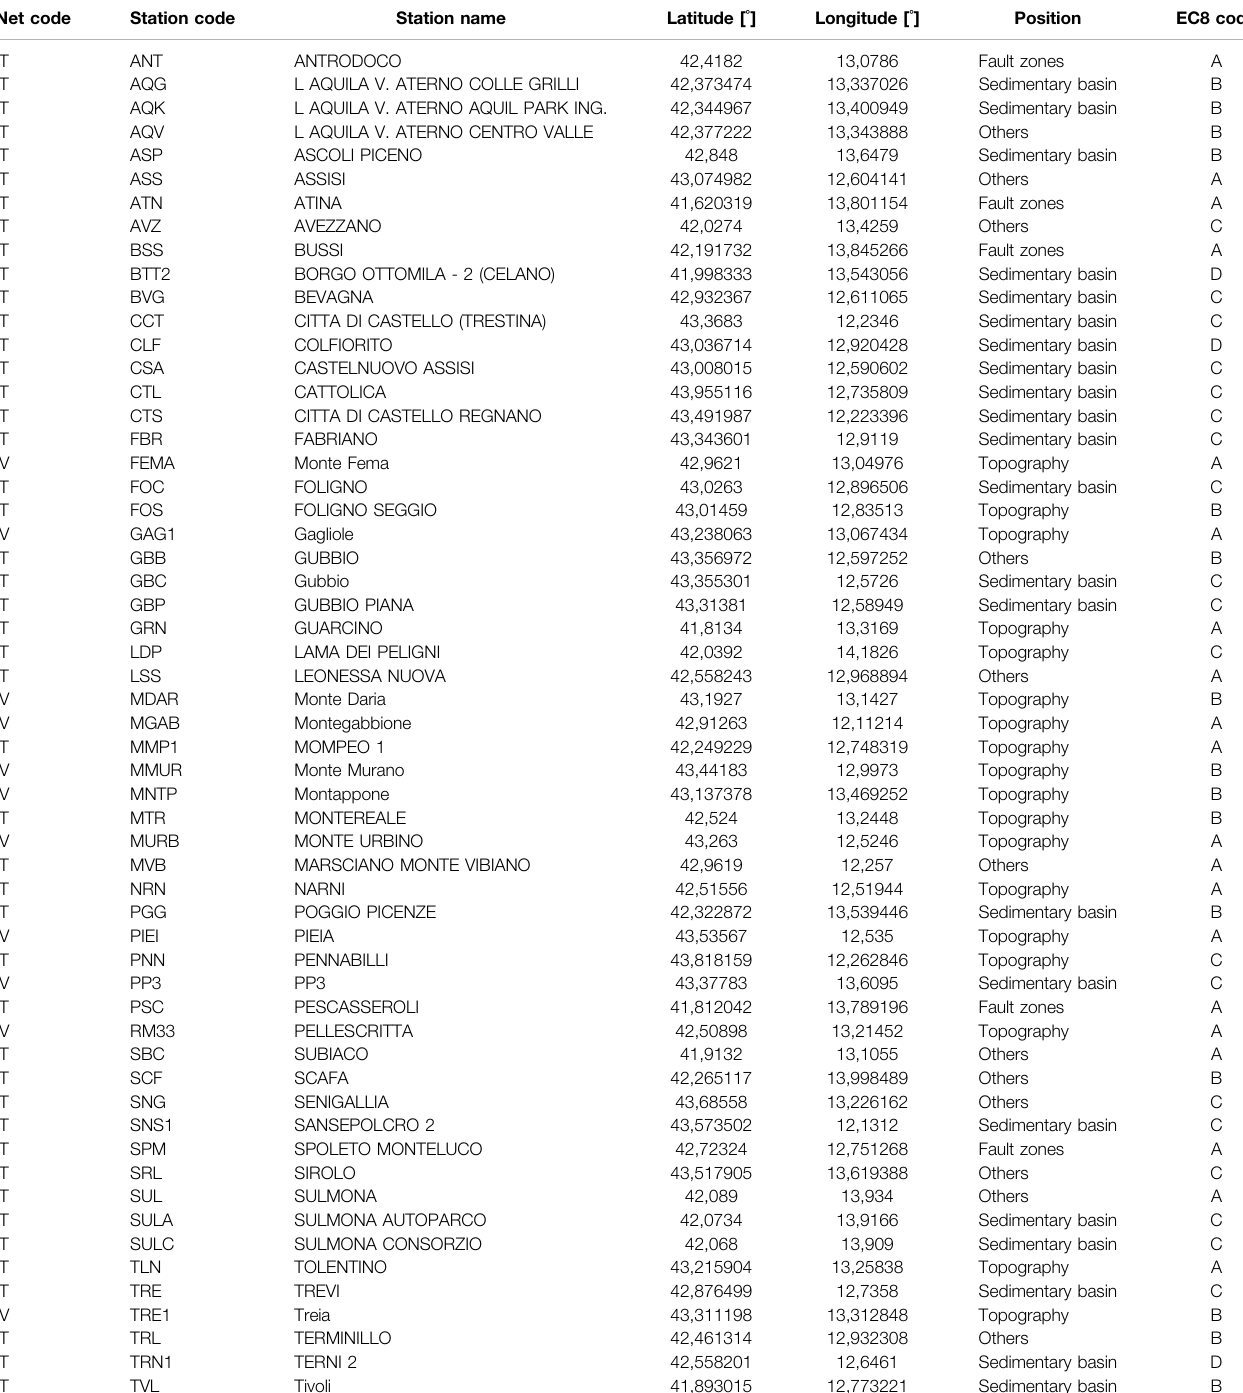
TABLE 1 | Station sample considered in this